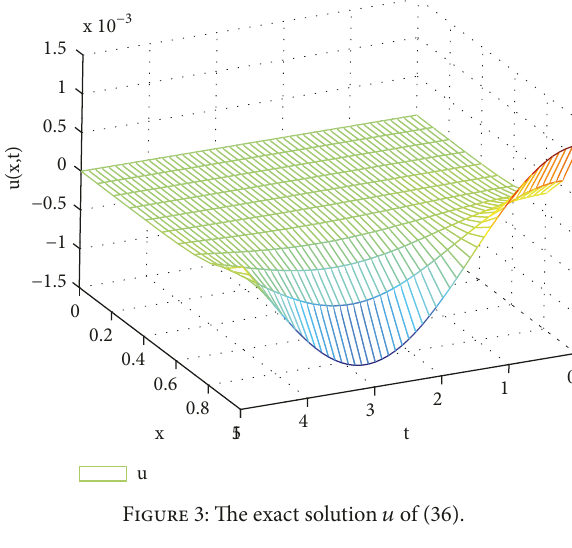
Figure 3: The exact solution 𝑢 of